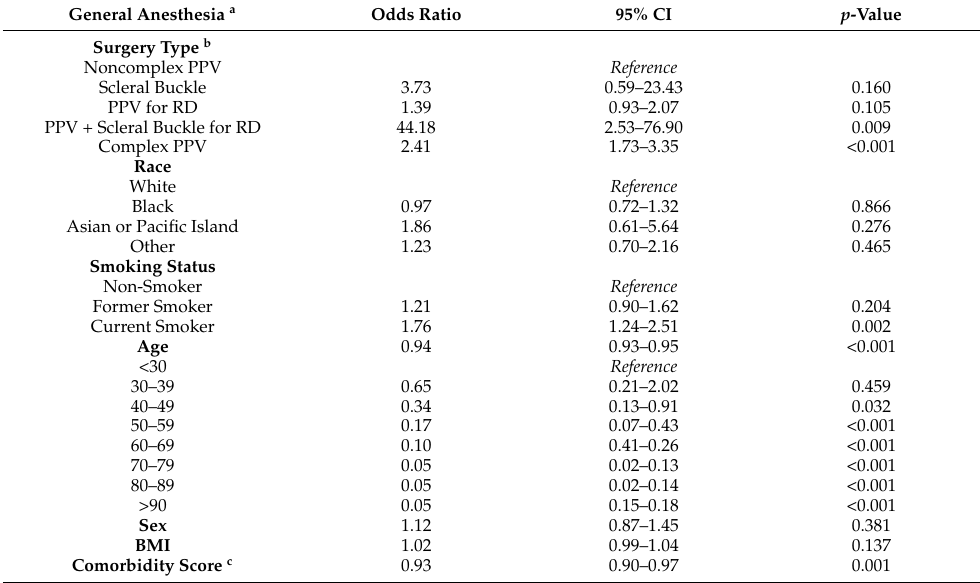
Table 2. Adjusted Odds Ratios for Performance of Vitreoretinal Surgery Type Under General Anesthesia.